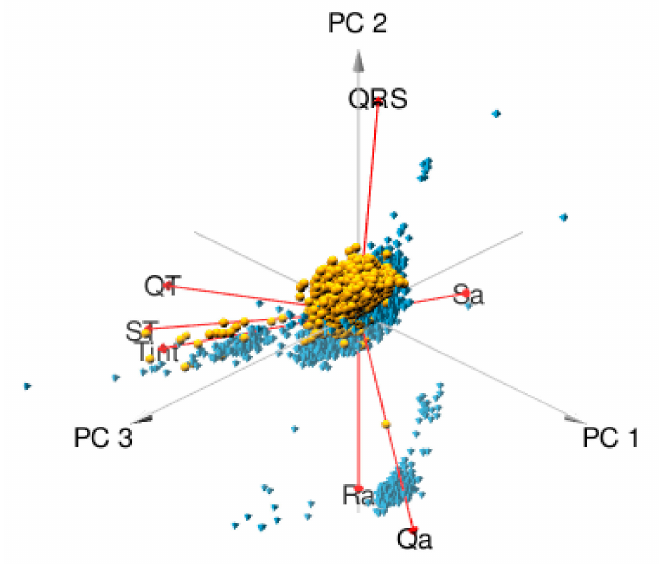
Figure 5. 3D plot of PCA results for both data subsets: yellow dots represent the morning state; blue pyramids—evening